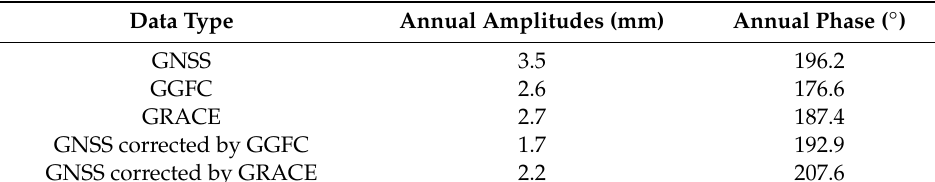
Table 1. Annual signals statistical results for the monthly time series.